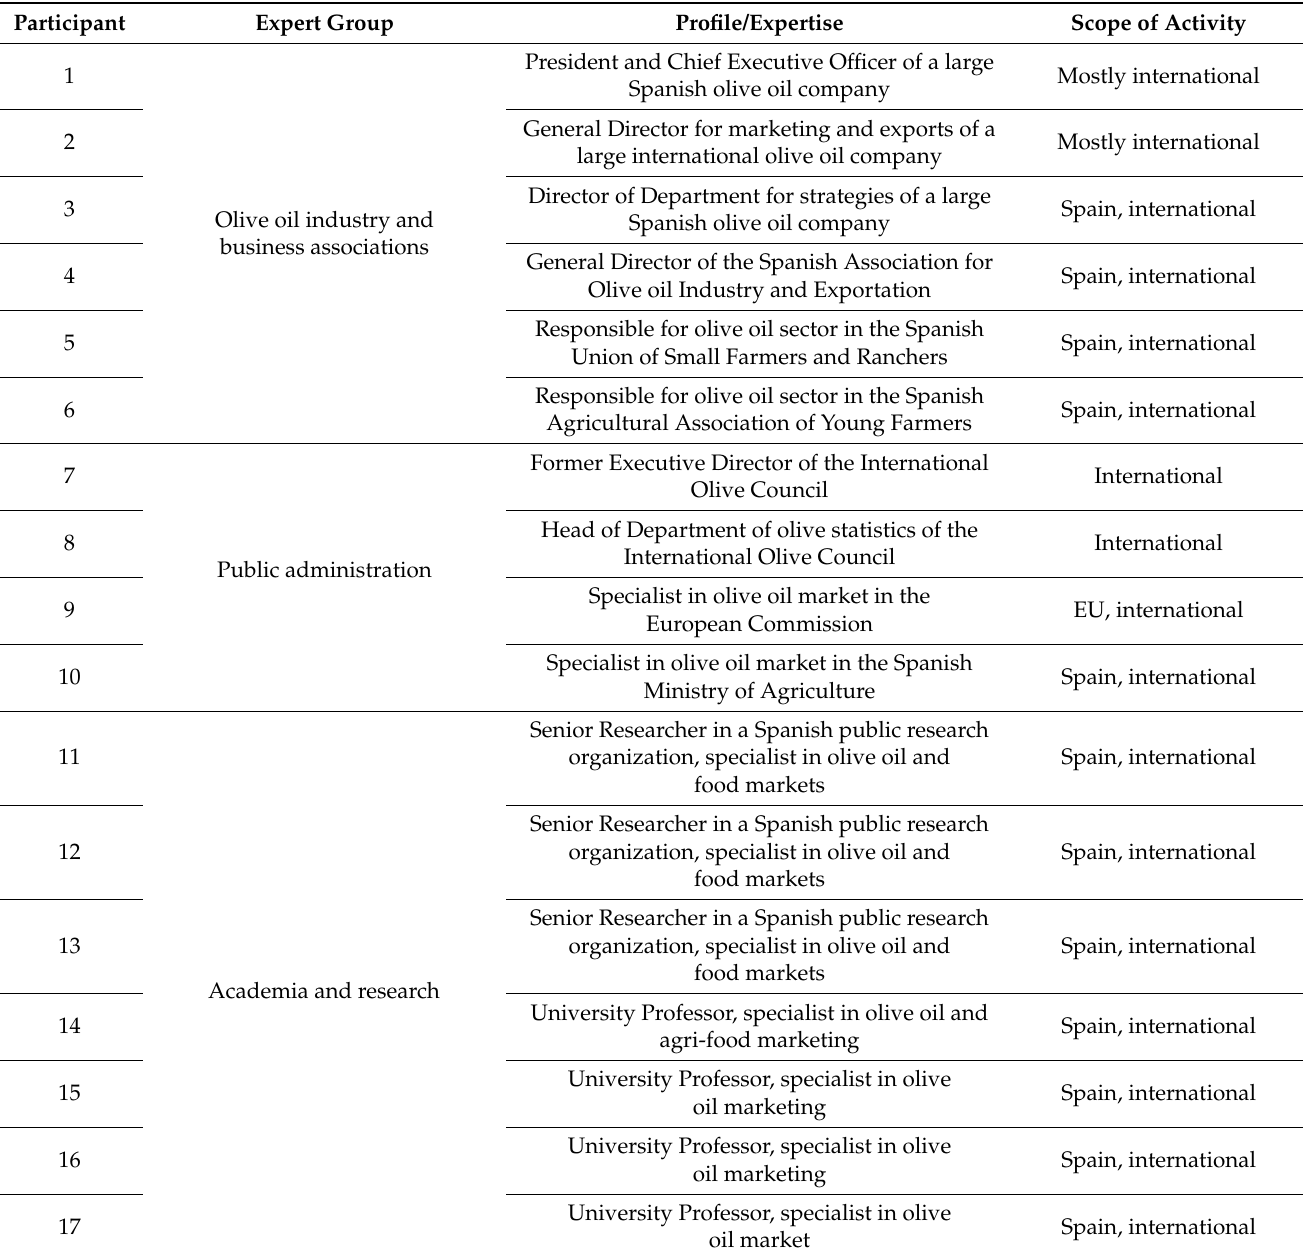
Table 1. Profile of Delphi